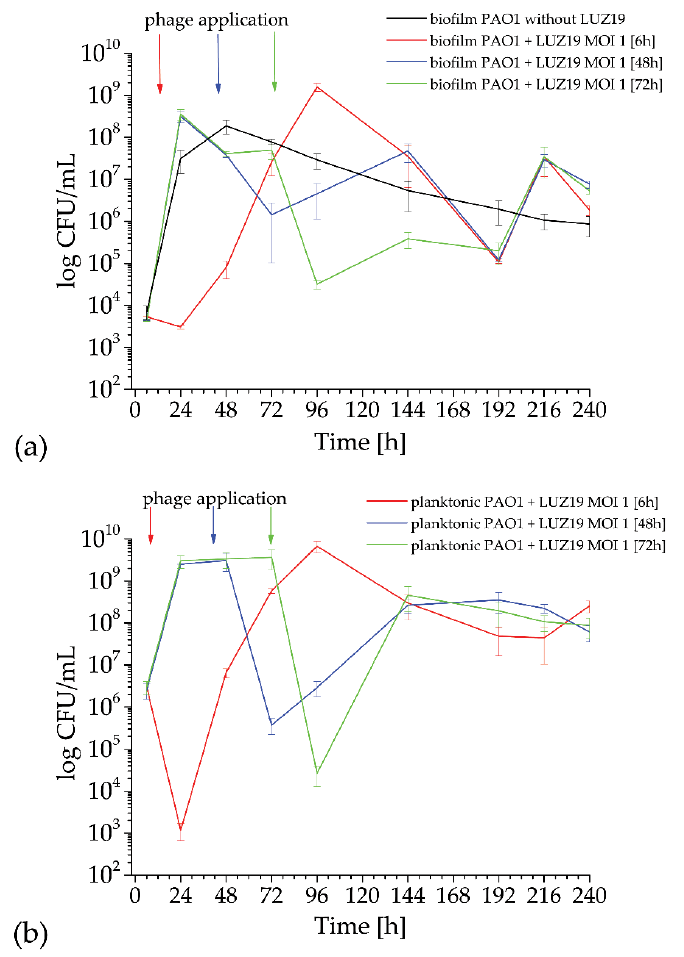
Figure 3. The colony count of P. aeruginosa PAO1 biofilm growth on QTF surface ( a ) and planktonic population ( b ) after phage LUZ19 infection. The error bars indicate the standard deviation. The results are presented as the means CFU / mL ± SD of three independent experiments in